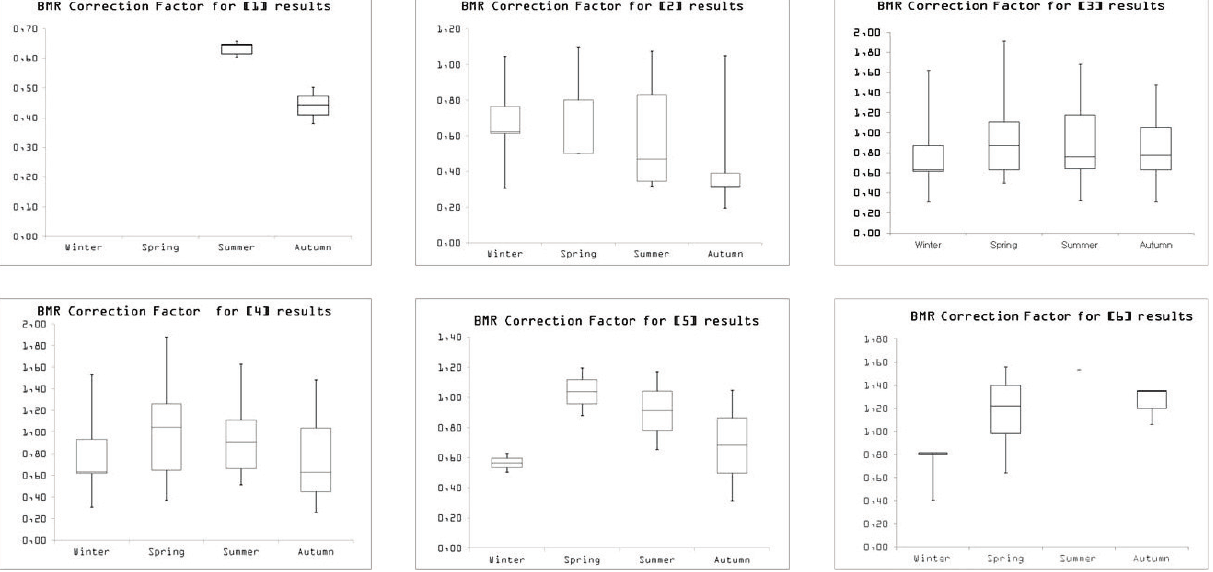
Fig. 5 Box and Whisker plot for Falco Rusticolus x Cherrug.